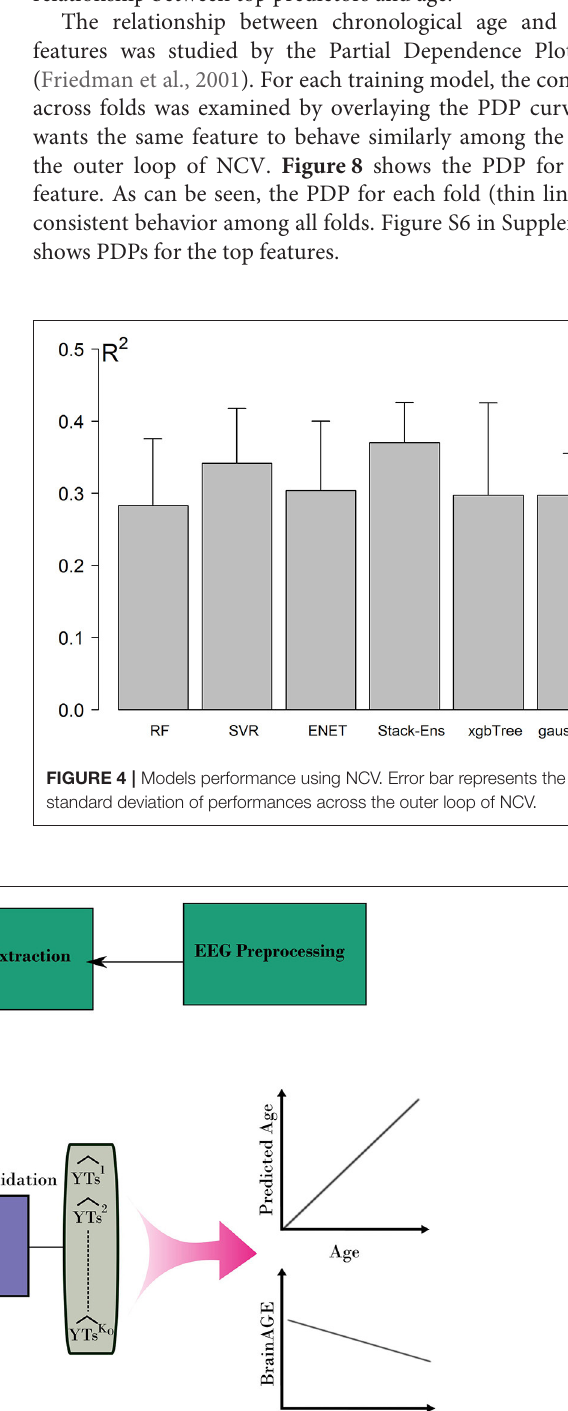
Frontiers in Aging Neuroscience |